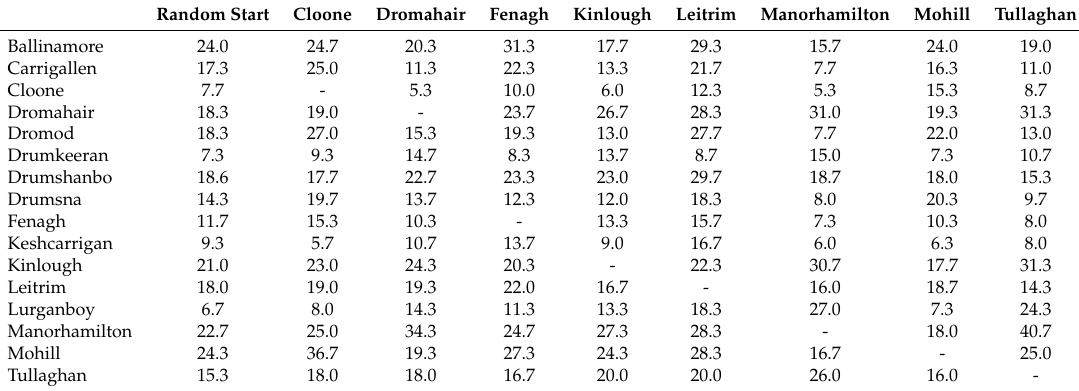
Table 8. Percent of runs leading to an outbreak in each of the 16 towns when the outbreak starts in a random location or one of the eight selected towns.